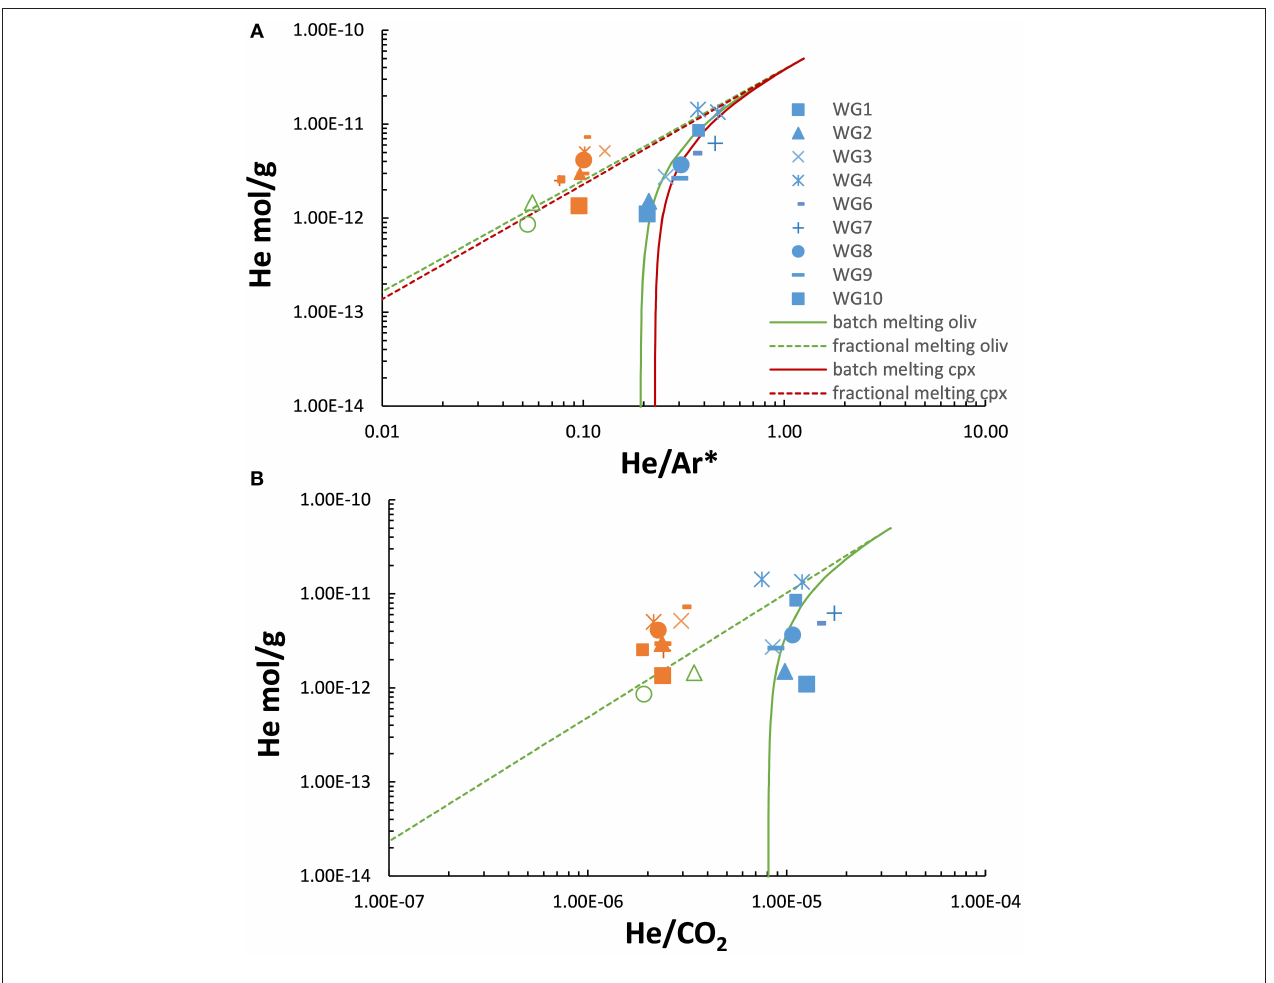
FIGURE 9 | (A) He/Ar* and (B) He/CO 2 vs. the He concentration. Modal batch and fractional equilibrium melting were modeled using the following equations: s  i C m i = C batch melting ...... C m i = cryst  melt F + D i · ( 1 − F ) # " where C m i and C s i are the concentrations of the i th species in the melt and solid source, respectively; F is the melting fraction, which varies from 0 to 1; and D the crystal–melt partitioning coefficient of the i th species. The coefficients for the crystal–melt partitioning of He, Ar, and CO 2 for Ol and Cpx are as follows: − 4 , Ol / melt D − 3 , Ol / melt D − 4 (assumed in order to fit data), Cpx / melt D Ol / melt D He = 1.7 × 10 Ar = 1.1 × 10 CO2 = 7 × 10